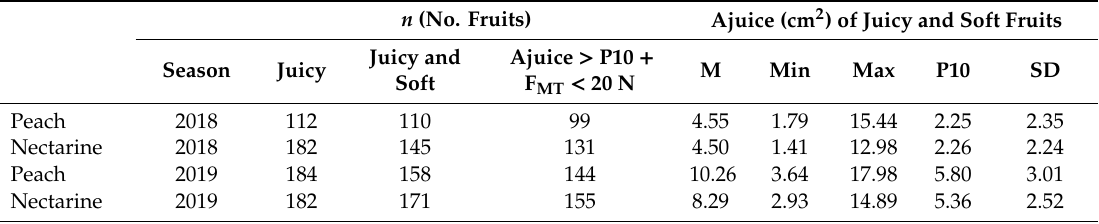
Table 3. Basic statistics by product and season for the variable juice area (Ajuice, cm 2 ). M (mean), P10 (10th percentile), and SD (standard deviation). Juicy means fruits with juiciness score above six and soft with F MT < 20 N. n (No. Fruits) Ajuice (cm 2 ) of Juicy and Soft Fruits